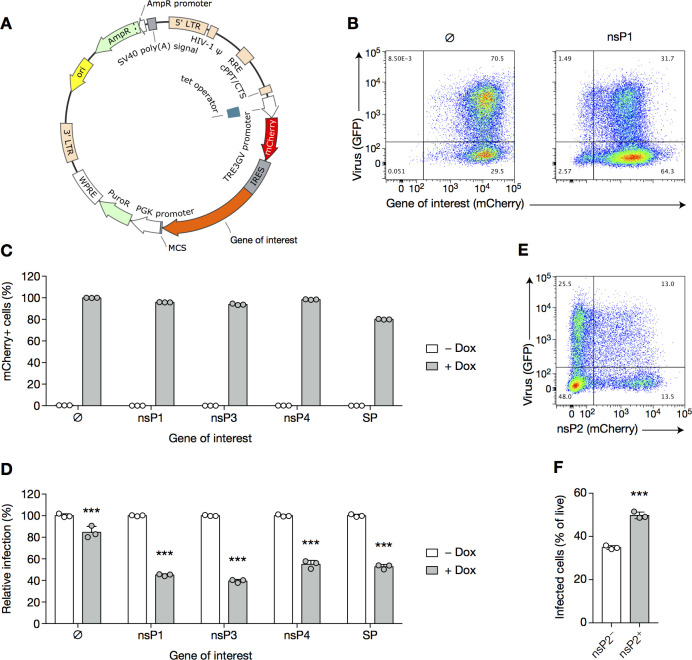
CHIKV SIE is not mediated by a single viral protein.(A) Schematic representation of the tetracycline-inducible construct. PuroR, puromycin resistance. LTR, long terminal repeat; HIV-1 ψ, packaging signal of human immunodeficiency virus type 1; PGK, mouse phosphoglycerate kinase 1; PuroR, puromycin resistance (puromycin N-acetyltransferase); AmpR, ampicillin resistance (β-lactamase); cPPT/CTS, central polypurine tract and central termination sequence of HIV-1; WPRE, woodchuck hepatitis virus post-transcriptional regulatory element; RRE, Rev response element of HIV-1; MCS, multiple cloning site, where genes of interest were cloned; IRES, internal ribosome entry site; ori, origin of replication. (B–D) 3T3 cells stably co-expressing the transactivator protein (3T3 transactivator) and the tetracycline-inducible construct described in (A) were treated with doxycycline (1 μg/mL) or left untreated for 16 h, then infected with CHIKV-GFP for 8 h at an MOI of 4, and subsequently harvested and analyzed by flow cytometry. Representative flow cytometry plots (B), percentages of cells expressing the transgene (C) and percentage of infected cells (D) and are displayed. SP, structural protein. (E, F) 3T3 cells stably expressing the transactivator protein (3T3 transactivator) were transfected with the construct containing nsP2 gene. Twenty-four hours post-transfection, cells were plated and treated or not with 1 μg/mL of doxycycline for 16 h, then challenged with CHIKV-GFP at an MOI of 4. Eight hours post-infection, they were harvested and analyzed by flow cytometry. Representative flow cytometry plot (E) and percentage of infected cells in the mCherry+and mCherry−populations (F) are shown. Bars indicate mean ± SD of biological triplicates and data are representative of two independent experiments. ***p < 0.001 (two-way ANOVA followed by Sidak’s post-test (C) or unpaired t-test (D)).